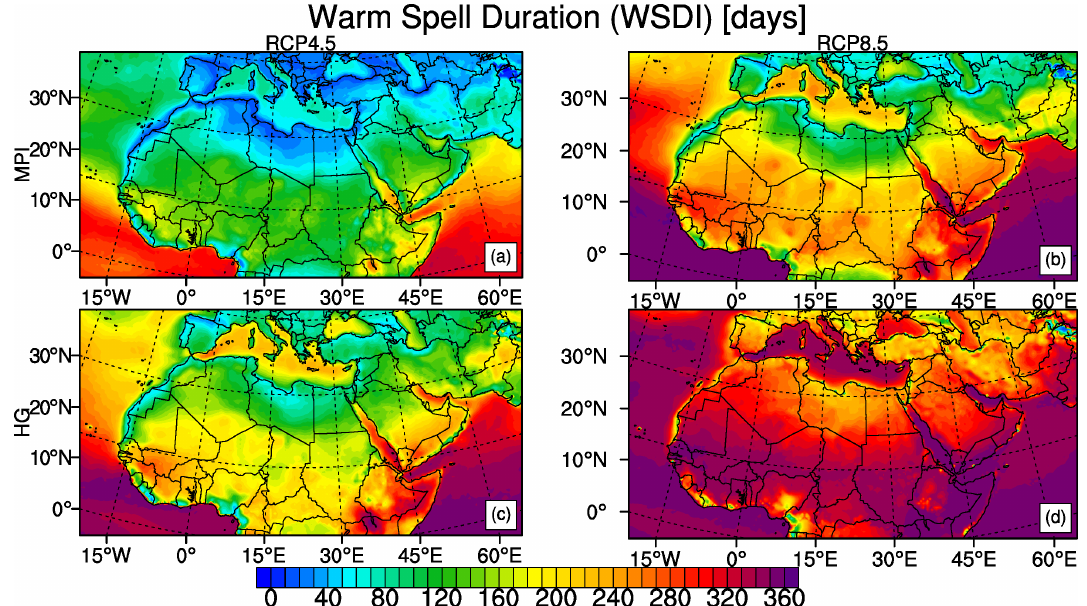
Figure 6. The temporally averaged changes in WSDI for the period of 2071–2100 displayed as differences (in days) with respect to the reference period 1971–2000 for the model MPI-ESM-MR with RCP4.5 ( a ) and RCP8.5 ( b ) and for the model HadGEM2-ES with RCP4.5 ( c ) and RCP8.5 ( d